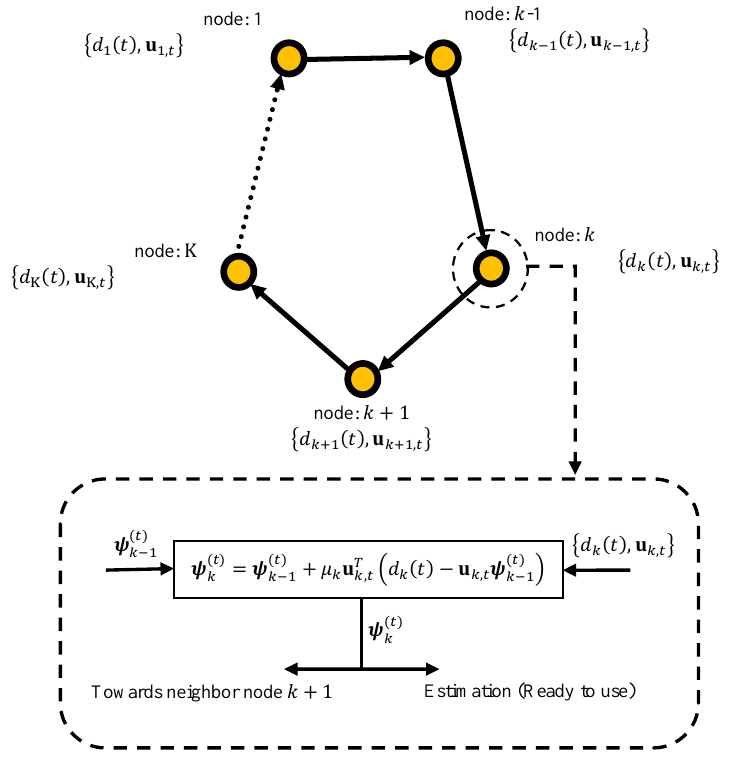
Figure 1. Data processing in an incremental